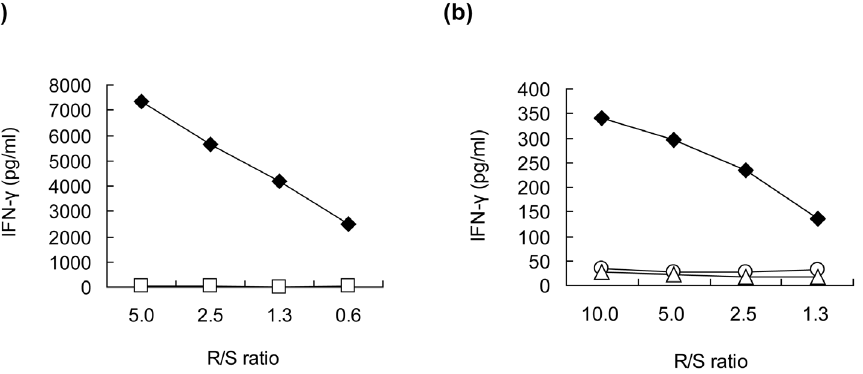
Figure 5. The HLA-A*02:06-restricted response of a HIG2-9-4 peptide-specific CTL clone. (a) A HIG2-9-4 peptide-specific CTL clone was induced from HLA-A*02:06-positive PBMCs, and stimulated with HLA-A*02:06-positive PSCCA0922 cells pulsed with the HIG2-9-4 peptide (close diamond) or HIV peptide (open square). (b) The HIG2-9-4 peptide-specific CTL clone was stimulated with COS7 cells expressing both HIG2 and HLA- A*02:06 (close diamond), or either HIG2 alone (open circle) or HLA-A*02:06 alone (open triangle). The IFN- c production in the culture supernatant was examined by ELISA. R/S ratio; responder/stimulator ratio. The representative results from three independent experiments are shown.